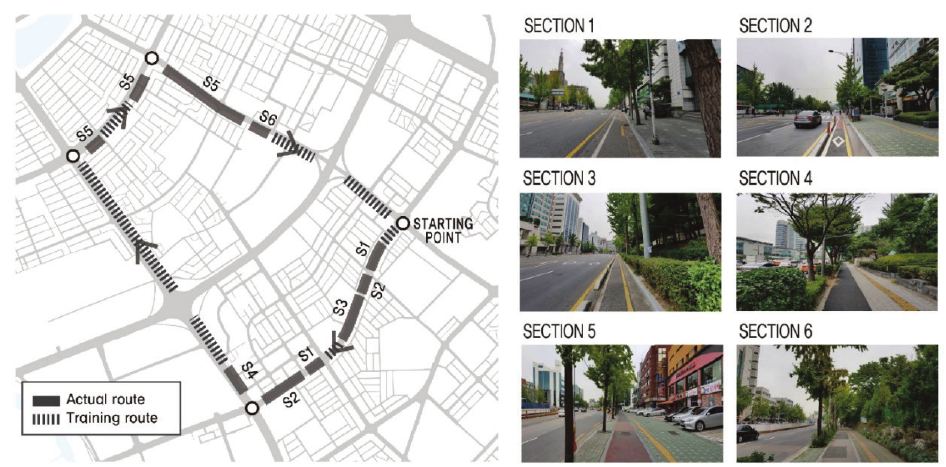
Figure 1. Cycling Route. Section 1 (upper left), Section 2 (upper right), Section 3 (middle left), Section 4 (middle right), Section 5 (bottom left) and Section 6 (bottom right) (source: author,